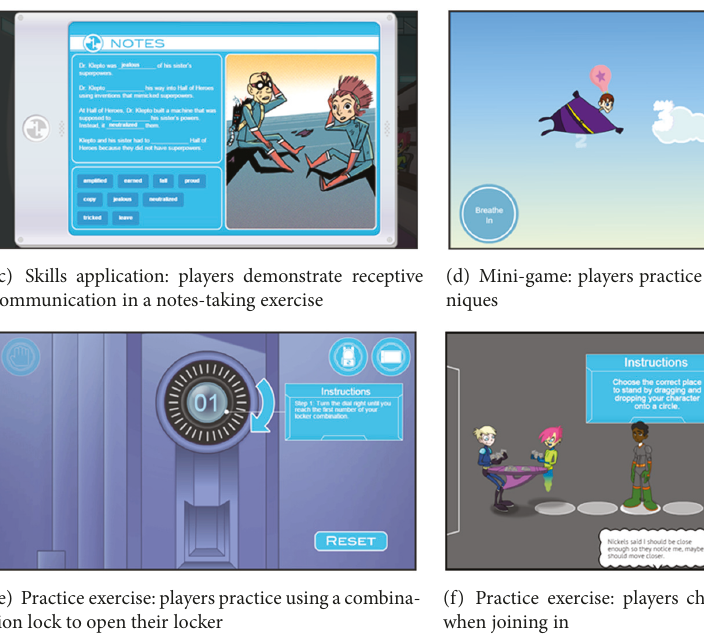
Figure 3: Example screenshots of Hall of Heroes